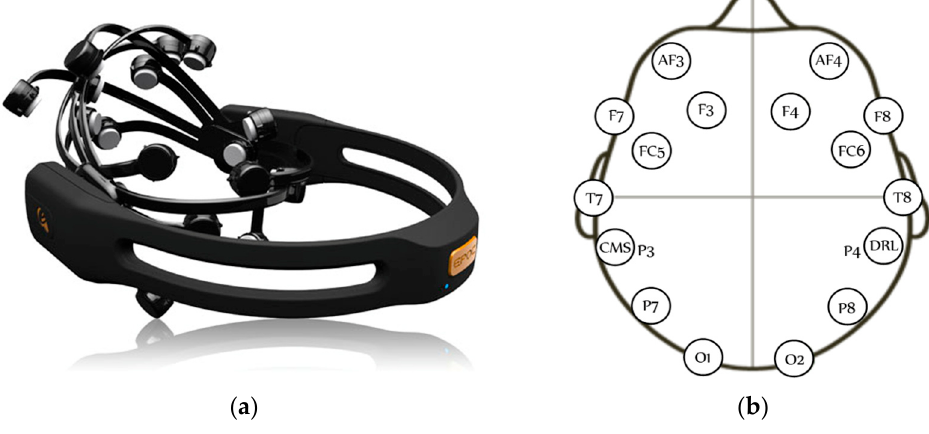
Figure 1. BCI System: ( a ) Emotiv Epoc headset; and ( b ) Emotiv Epoc electrode arrangement.